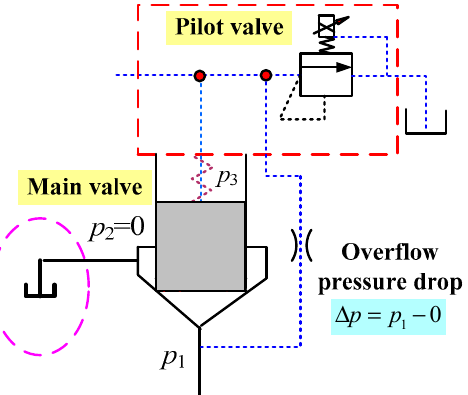
Figure 2. Working principle diagram of traditional proportional relief valve.